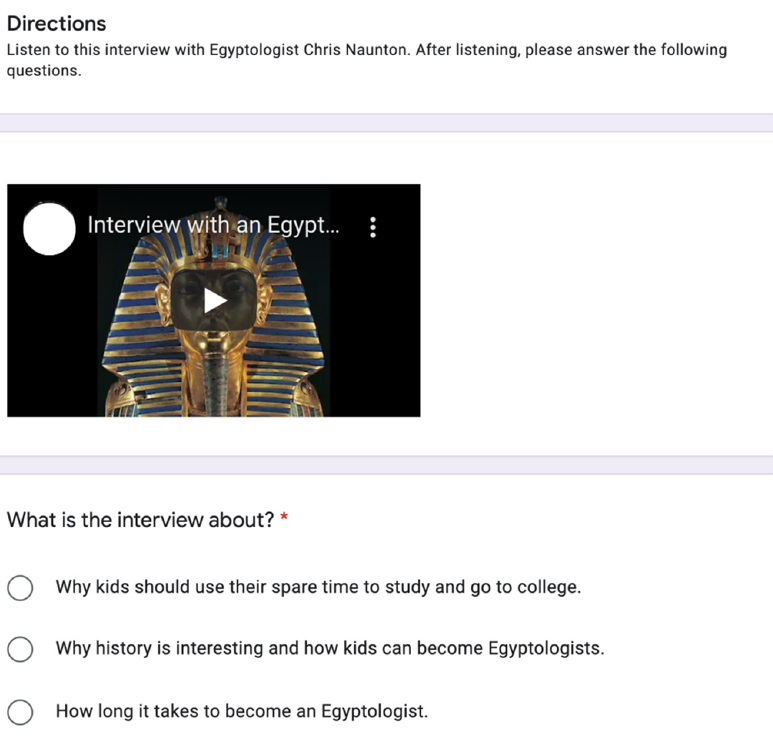
Figure 9. Listening assessment example (eighth graders). Note: * indicates that a test-taker’s response is required.